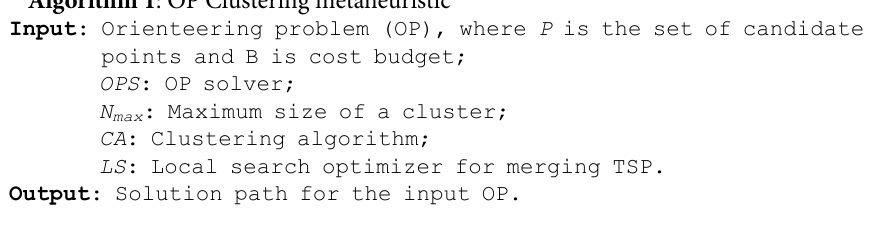
Algorithm 1 : OP Clustering